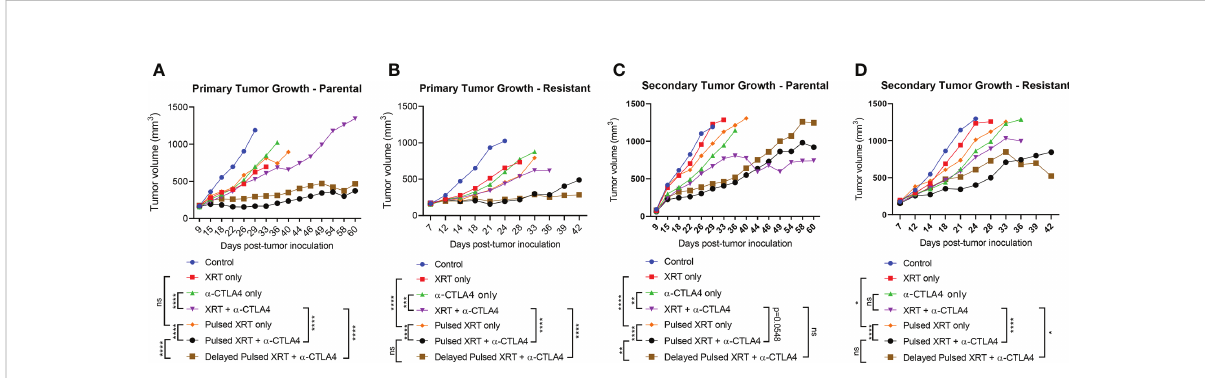
FIGURE 3 Pulsed radiation with anti-CTLA-4 checkpoint inhibitor generated a reverse abscopal effecton primary tumors of both 344SQ-Parental and 344SQ-Resistant models. (A) Primary tumor growth curves in the 344SQ-Parental model. (B) Primary tumor growth curves in the 344SQ- Resistant model. (C) Secondary tumor growth curves in the 344SQ-Parental model. (D) Secondary tumor growth in the 344SQ-Resisatnt model. Growth lines were compared between groups using two-way ANOVA and signi fi cance was set at p < 0.05. *p < 0.05, **p < 0.01, ***p<0.001, ****p <